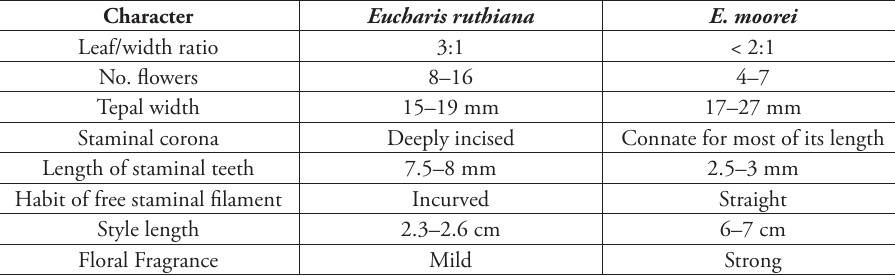
Table 2. Contrasting features of Eucharis ruthiana and E. moorei